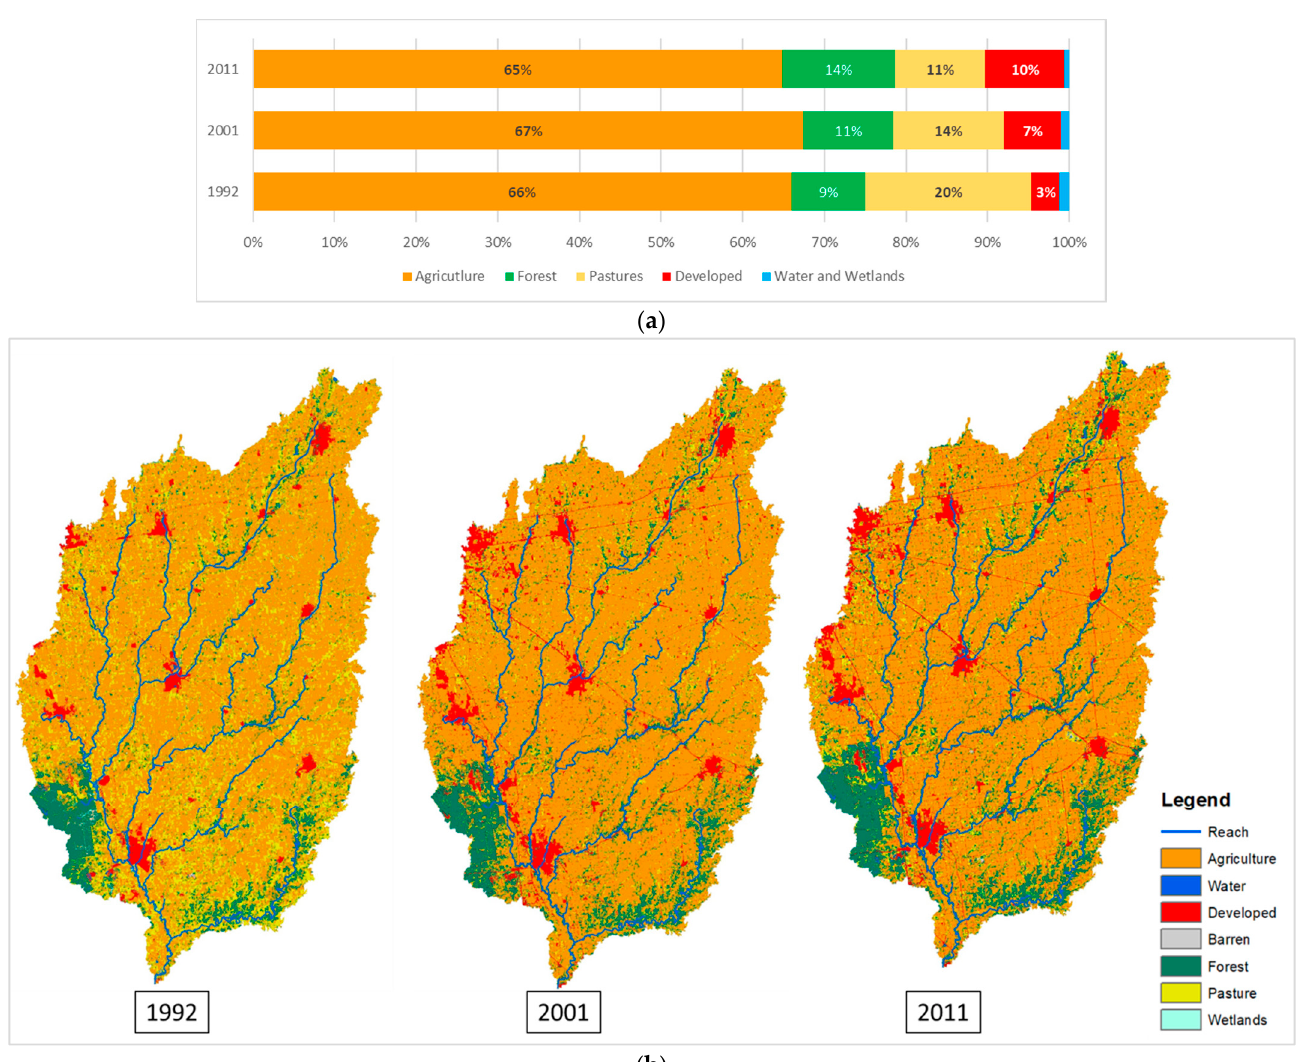
Figure 2. Land use distribution in the UEFWR basins ( a ) and land use maps integrated in the databases for each of the configuration periods: C1—1992, C2—2001, and C3—2011 ( b ).